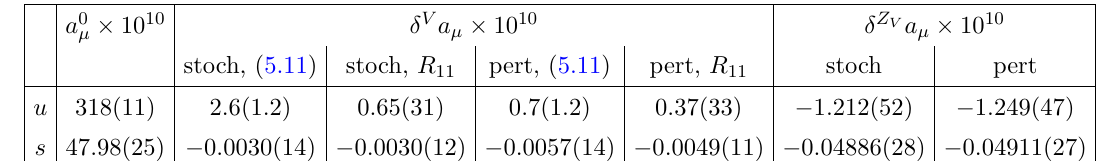
Table 9 . Summary of our results for the QED correction to a mass of (cid:25) 340 MeV. Results are shown for the stochastic and perturbative method.